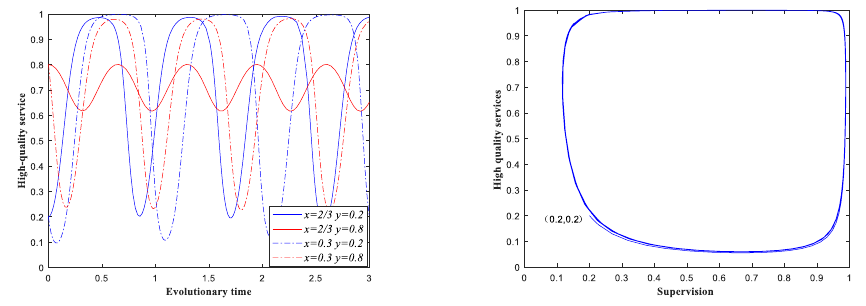
Figure 5. Evolutionary process of scenario 4 under static subsidy.